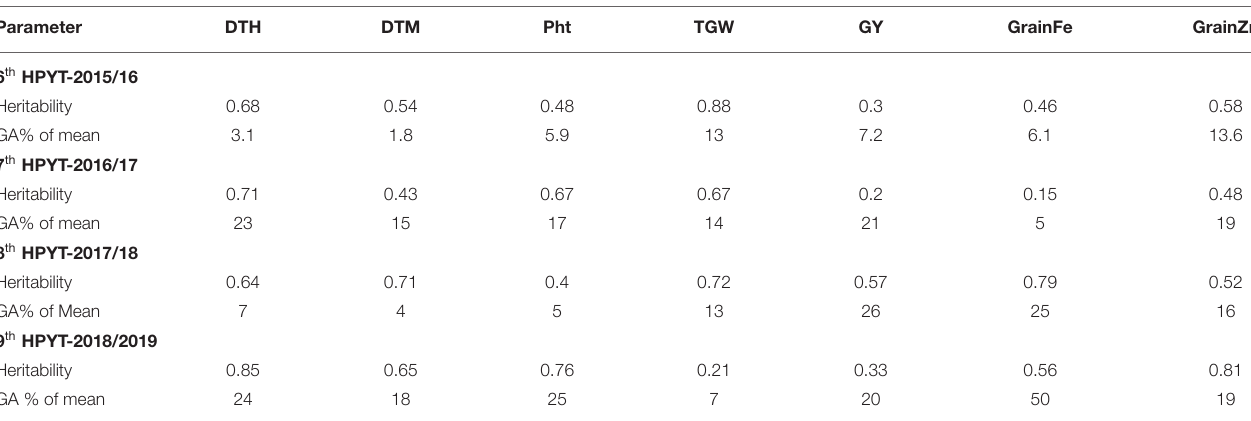
TABLE 2 | Heritability and genetic advance of studied traits of HPYTs using BLUP values, 2015/16–2018/19 seasons.